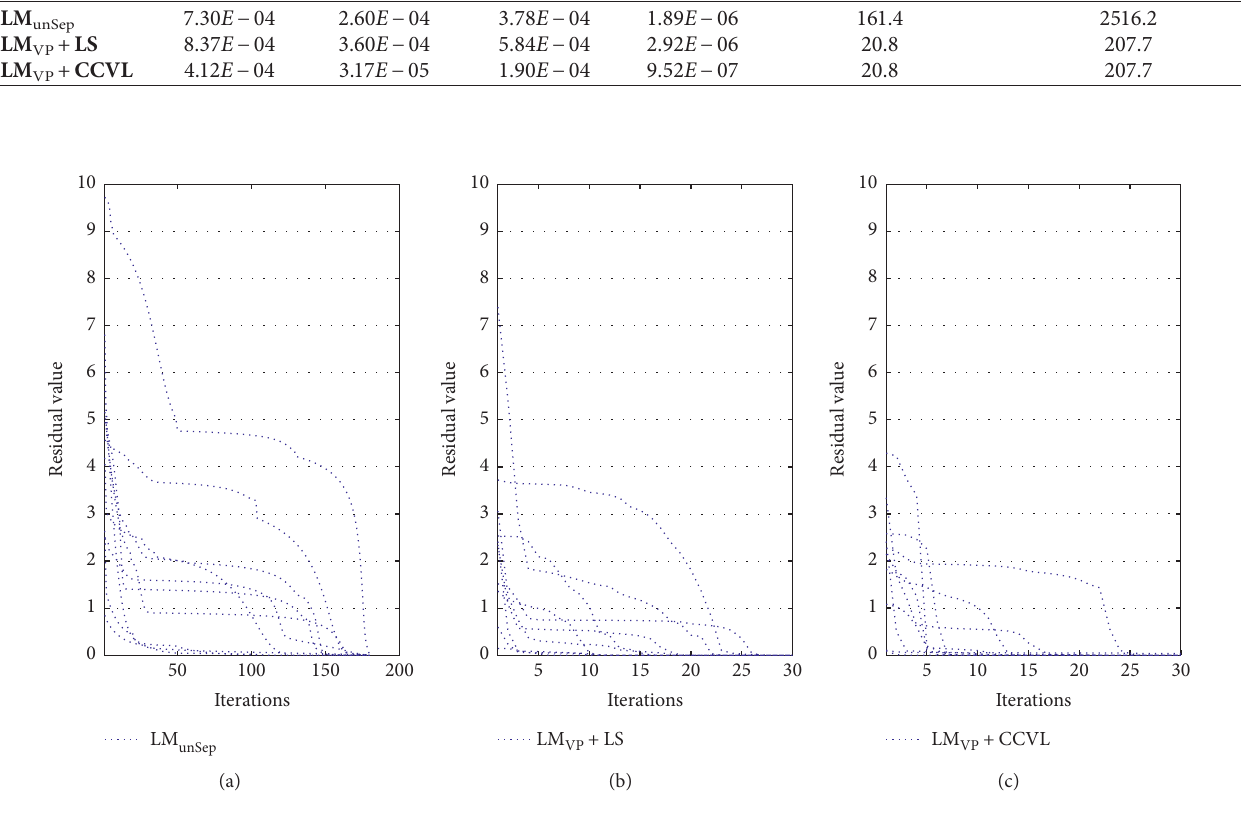
Table 6: Sums of the squared residuals between predicted value obtained by the three methods and the true observations in Example 2. Method